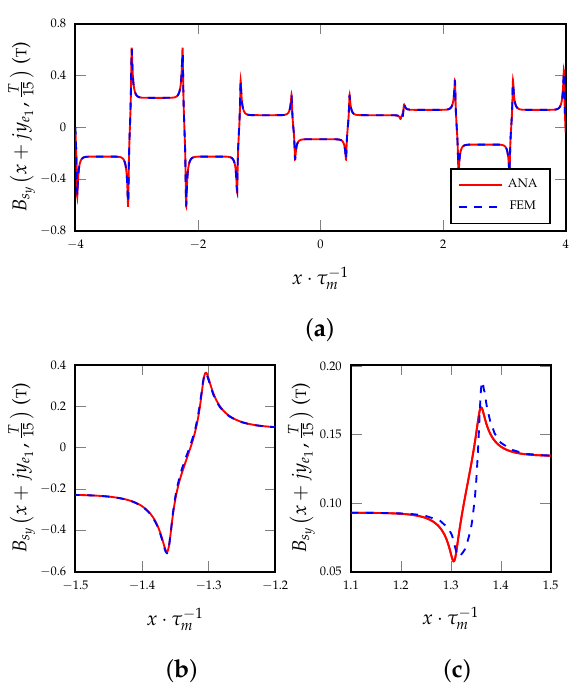
Figure 13. Analytical (slotted current sheets model) and FEM (slotted machine of Figure 4a) armature reaction flux density normal component on the exploration line at y e